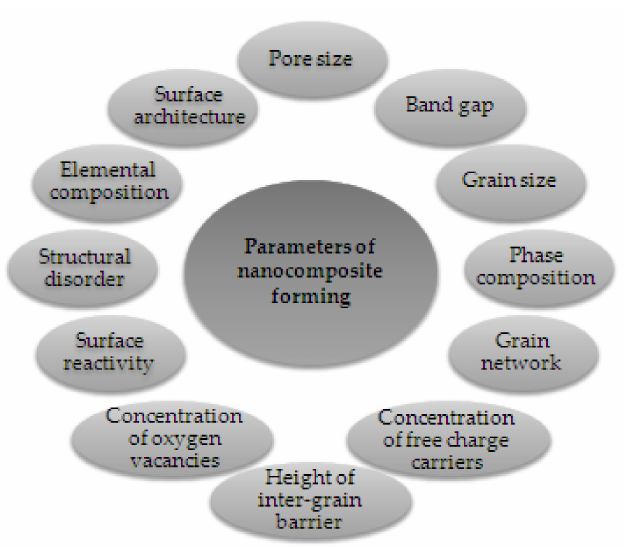
Figure 6. Features influenced by metal oxide–metal oxide nanocomposite formation. Elaboration from reference